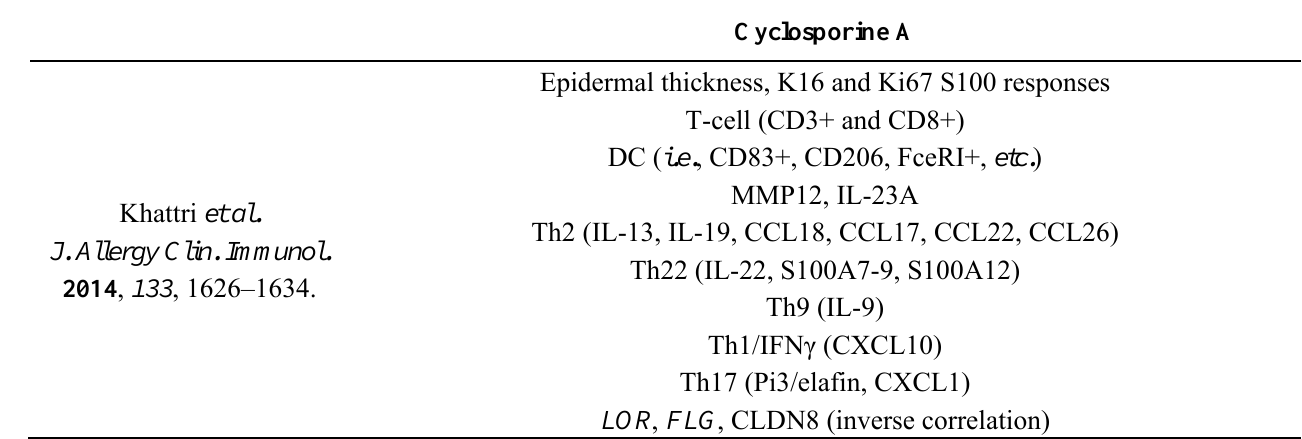
Table 2. Treatment response